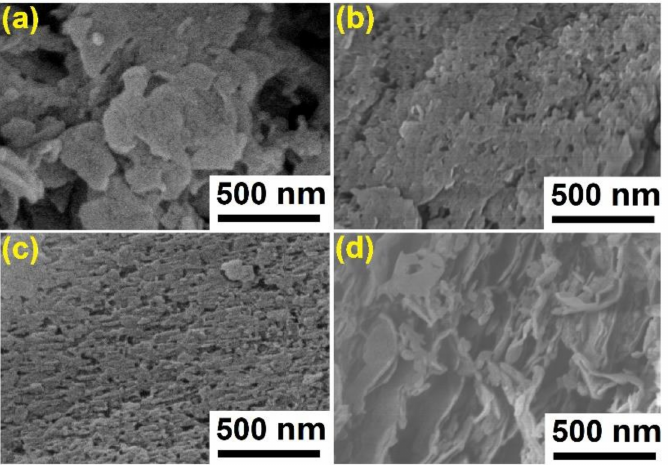
Figure 5. FESEM micrograph of GCN samples ( a ) GCN-B; ( b ) GCN-450; ( c ) GCN-500; ( d ) GCN-550.